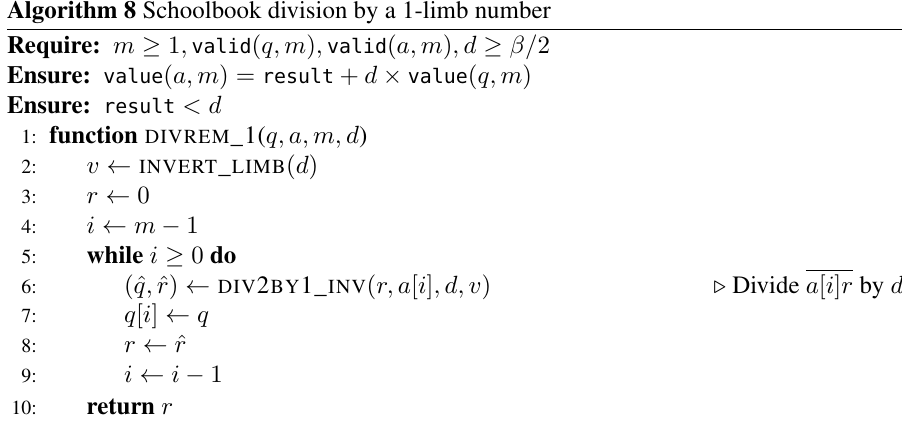
Algorithm 8 Schoolbook division by a 1-limb